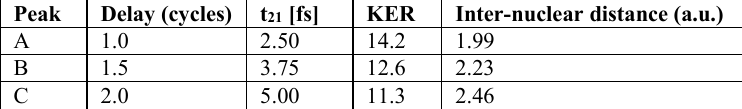
Table 1. Timing and KER values extracted from Fig. 1(a) for the points marked A, B and C together with the inter-nuclear distance calculated from